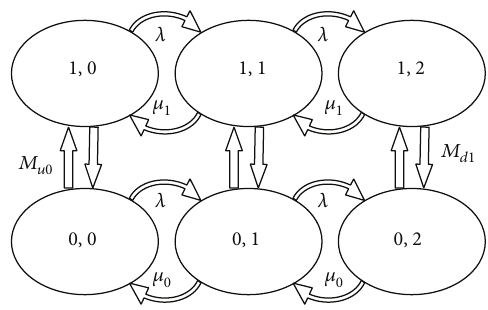
Figure 3: 2 × 3 mobile network QoS